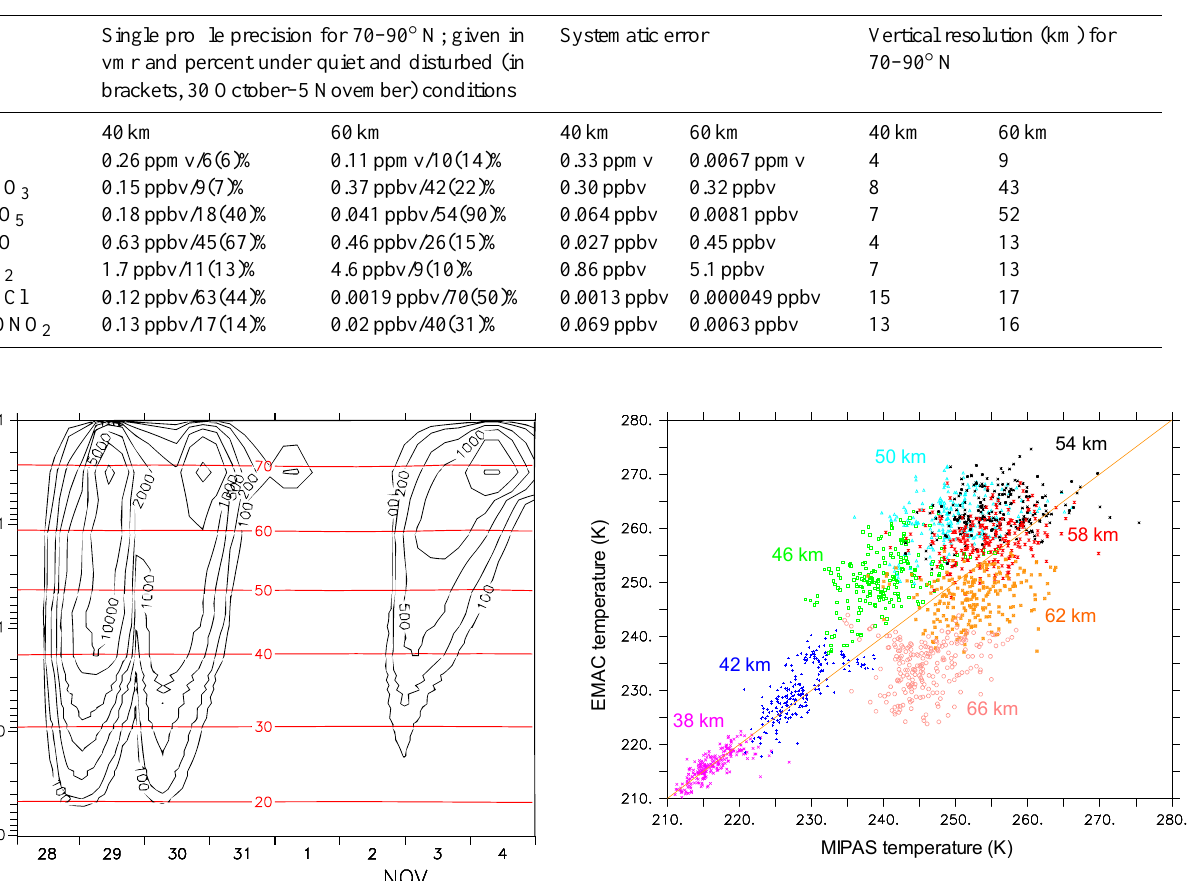
Fig. 3. Comparison of zonal average temperatures of MIPAS and EMAC for 70–90 ◦ N for 26 October–30 November